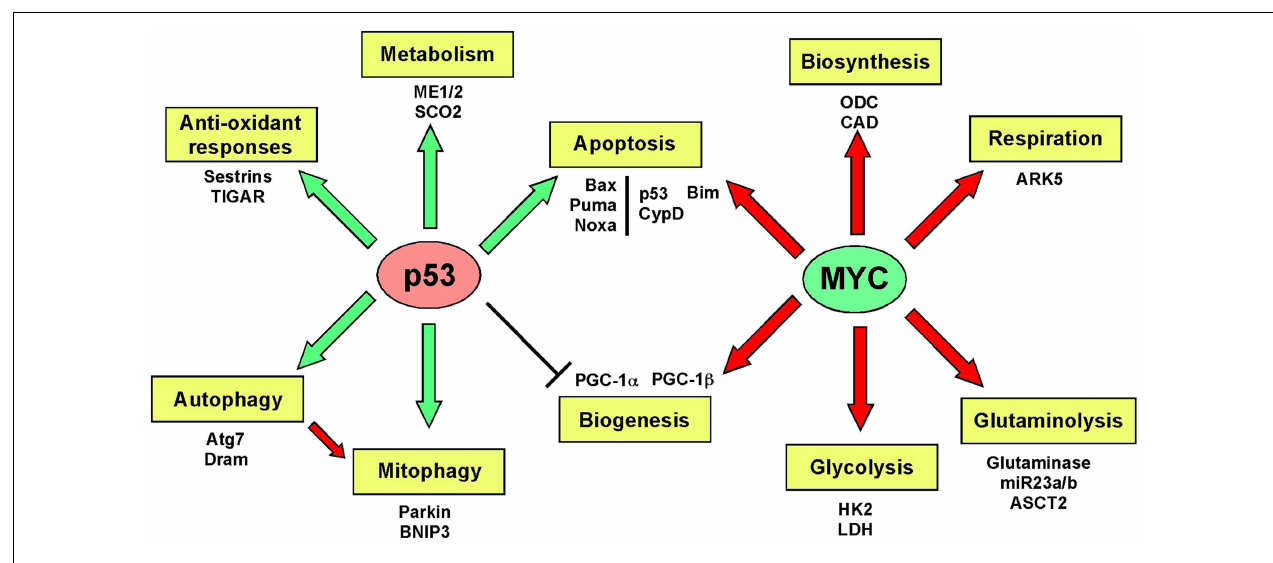
significant tumor related genes in the human genome, have been shown to modulate several different aspects of mitochondrial function and in some instances, this has been shown to be key to their role in cancer, as discussed in greater length in the